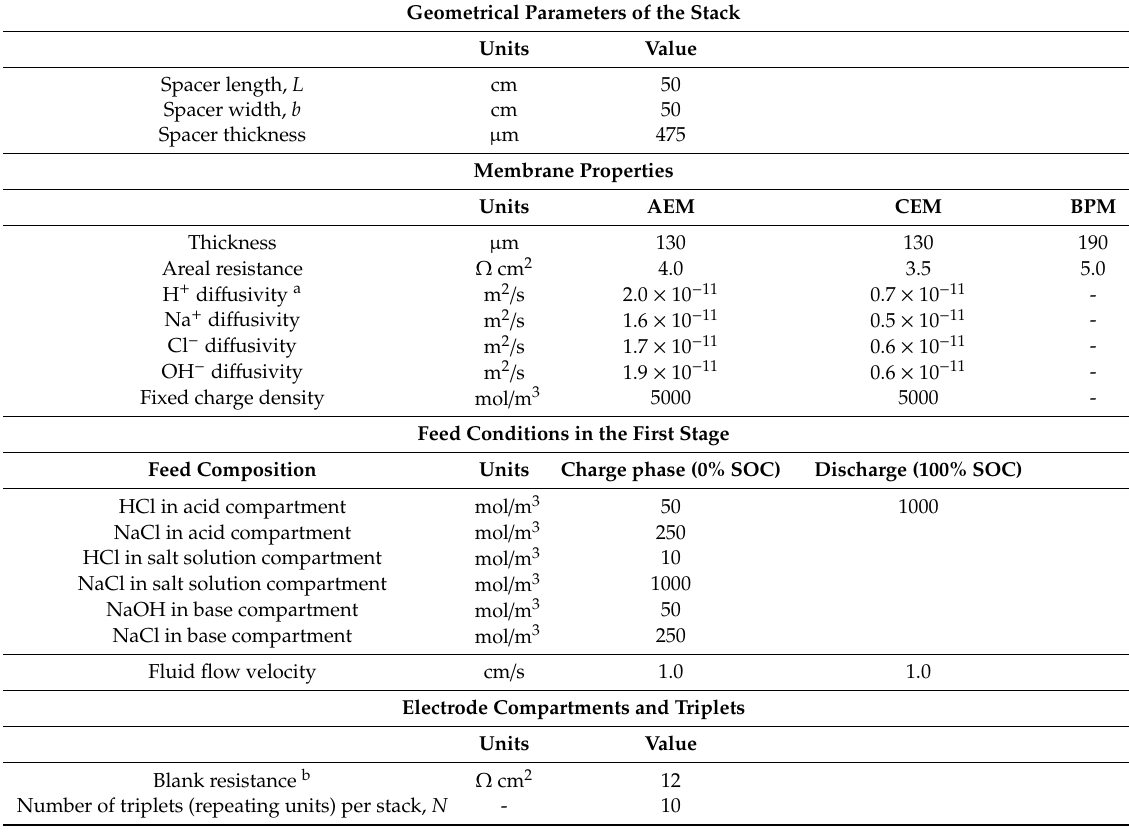
Table 2. Overview of main input parameters used in the sensitivity analysis. Adapted from Reference